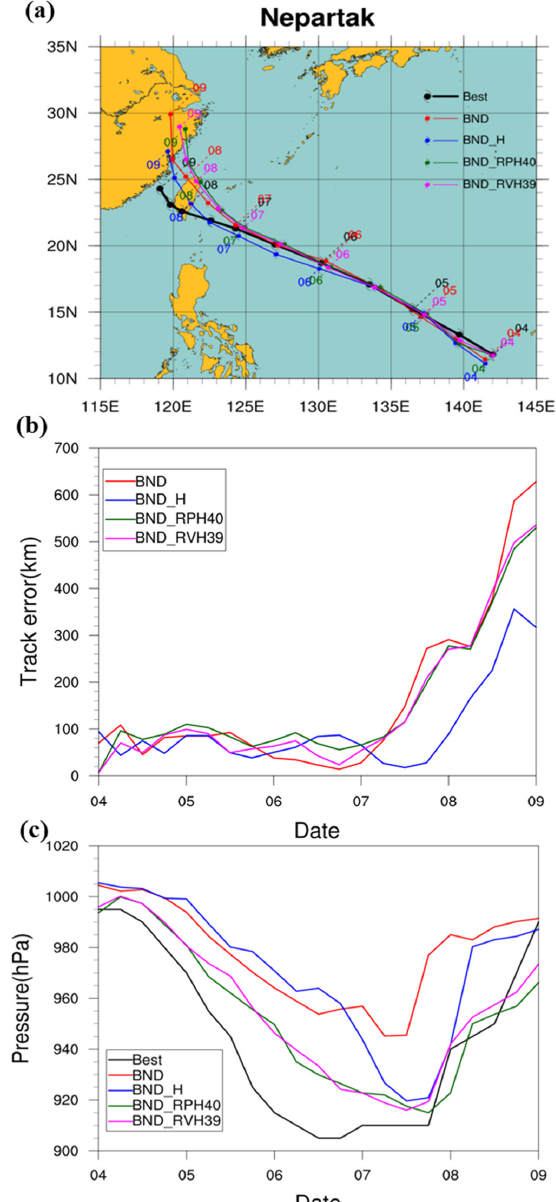
Figure 13. ( a ) The CWB best track (black line) and the forecasted tracks for BND_H (blue line), BND_RVH (pink line), and BND_RPH (green line) for Typhoon Nepartak. ( b ) as in ( a ) but for the track errors with forecast time, and ( c ) as in ( a ) but for the central sea-level pressure. The numbers following the case names indicate the number of cycle runs.